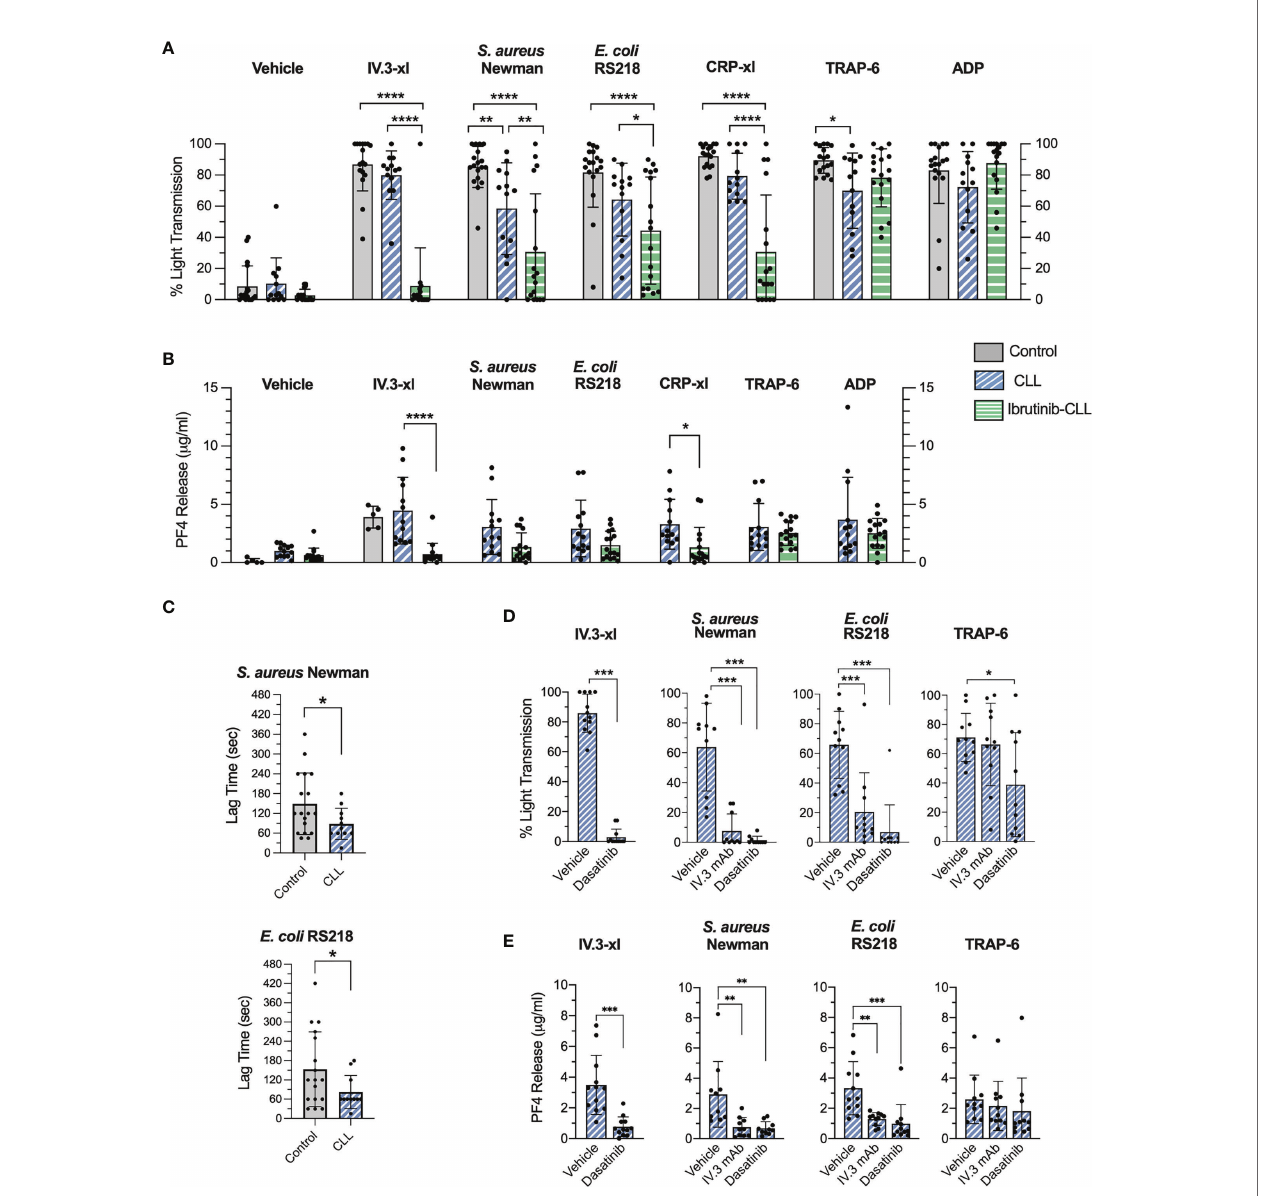
FIGURE 1 | CLL platelet aggregation and secretion in response to bacteria and IV.3 mAb mediated Fc g RIIA crosslinking are impaired in CLL patients taking ibrutinib. (A) Characterization of platelet aggregation responses in healthy controls (n=17-18), untreated (n=13) and ibrutinib-treated (n=16-17) CLL patients. PRP samples were stimulated with crosslinked IV.3 mAb (IV.3-xl; 4 m g/ml mAb IV.3 followed by 30 m g/ml F(ab ’ )2 rabbit anti-mouse IgG), S. aureus Newman, E. coli RS218, 3 m g/ ml CRP-xl, 3 m M TRAP-6, or 10 m M ADP. Aggregation was recorded by light transmission aggregometry. Reactions were run for 20 minutes from onset of aggregation for IV.3-xl and bacteria, and 10 minutes for the rest of agonists, and maximum aggregation was calculated. (B) Characterization of a -granule secretion in ibrutinib-untreated (n=13) and treated (n=15-16) CLL patients. Supernatants from PRP aggregation reactions were collected at 20 minutes of onset of aggregation for IV.3-xl and bacteria, and 10 minutes in the case of other agonists. Levels of PF4 as a marker of a -granule secretion were measured by PF4 ELISA. (C) Lag time for onset of platelet aggregation in response to bacteria. For healthy donor and ibrutinib-untreated platelet samples, the lag time for onset of aggregation (e.g., time between bacteria injection and start of platelet aggregation) was calculated in those cases in which aggregation took place in response to S. aureus Newman (healthy controls, n=18; CLL, n=11) and E. coli RS218 (healthy controls, n=17; CLL, n=11). (D) Effect of Fc g RIIA and Src inhibition on ibrutinib-untreated CLL platelet aggregation. PRP samples (n=10-12) were incubated with 4 m M dasatinib (Src inhibitor) for 2 min, 20 m g/ml IV.3 mAb (Fc g RIIA inhibitor) for 10 minutes, or vehicle before being stimulated with agonists and monitored by light transmission aggregometry. (E) Effect of Fc g RIIA and Src inhibition on ibrutinib-untreated CLL platelet a - granule secretion. Supernatants from aggregation reactions above were collected at 20 minutes of onset of aggregation for IV.3-xl and bacteria, and 10 minutes in the case of other agonists. PF4 release was measured by ELISA. Data is shown as mean ± SD. Statistical signi fi cance was calculated using two-way ANOVA for (A, B) , or one-way ANOVA for (D, E) , followed by Tukey ’ s or Sidak ’ s multiple comparison correction. An unpaired t-test was performed for (C) (*p ≤ 0.05, **p ≤ 0.01, ***p ≤ 0.001, ****p ≤